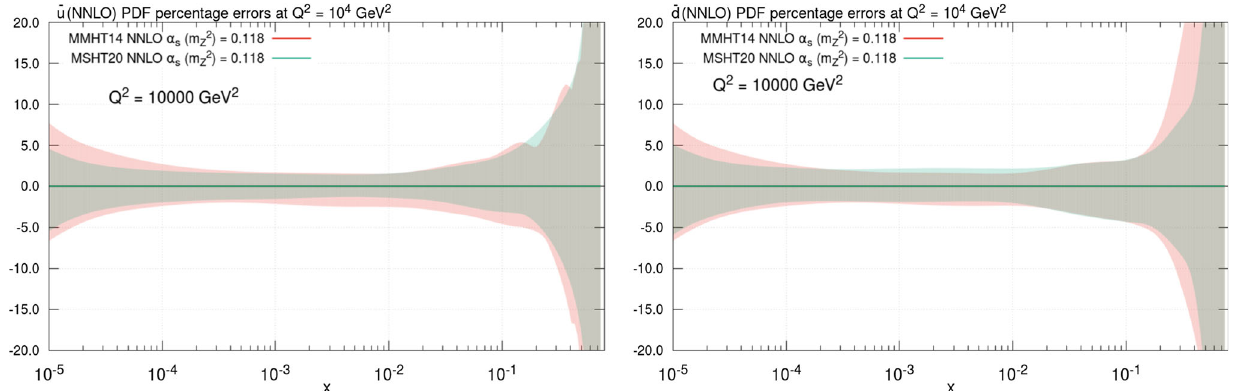
Fig. 21 Percentageuncertaintiesof(left)Upantiquarkand(right)DownantiquarkPDFs,forMSHT20andMMHT14atNNLOand Q 2 = 10 4 GeV 2